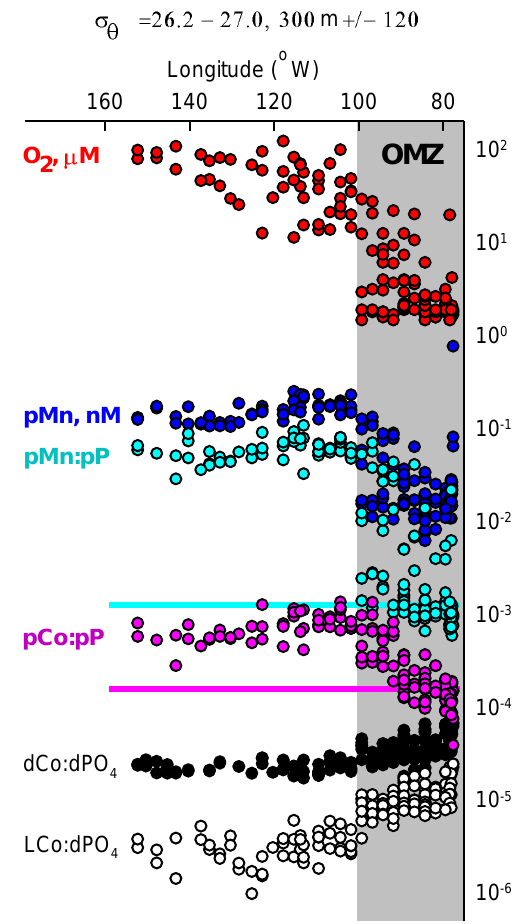
Figure 9. Redox control of Co and Mn scavenging. Within mesopelagic waters ( σ θ = 26.2–27.0kgm − 3 , mean depth of 300m), high O 2 in ventilating water masses results in a sharp re- dox boundary at the edge of the OMZ (red circles, scale inµM). Particulate Mn (pMn) increases across the oxic–anoxic bound- ary at 100 ◦ W (blue circles, in nM) and implies stabilization of Mn oxides. BothpMn : pP and pCo : pP (cyan and pink cir- cles, respectively; units are MM − 1 ) increase across the OMZ boundary, exceeding predicted values from remineralization of bio- genic material from the surface ocean (1.26 × 10 − 3 meanpMn : pP and 1.57 × 10 − 4 pCo : pP for 0–50m (MM − 1 ) , cyan and pink lines, respectively). Dissolved-phase dCo : dPO 4 (black circles) and LCo : PO 4 (white circles) also decrease west of the OMZ bound- ary and show scavenging of dCo and LCo in the mesopelagic zone (units are MM − 1 )